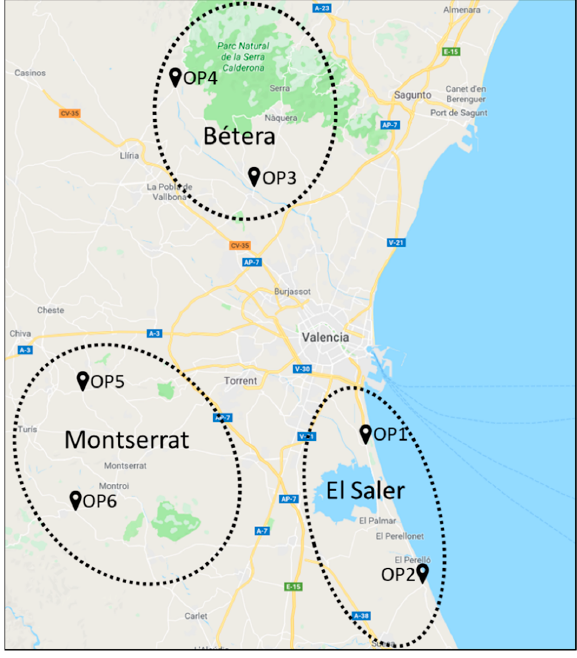
Figure 2. Study areas and observation points (OP).